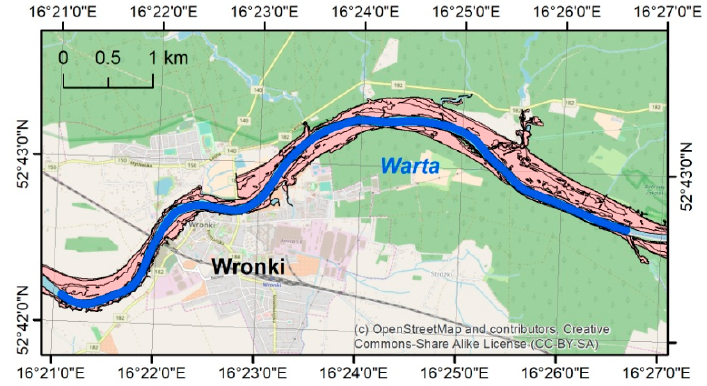
Figure 1. Map presenting the first study areas—the reach of the Warta river.